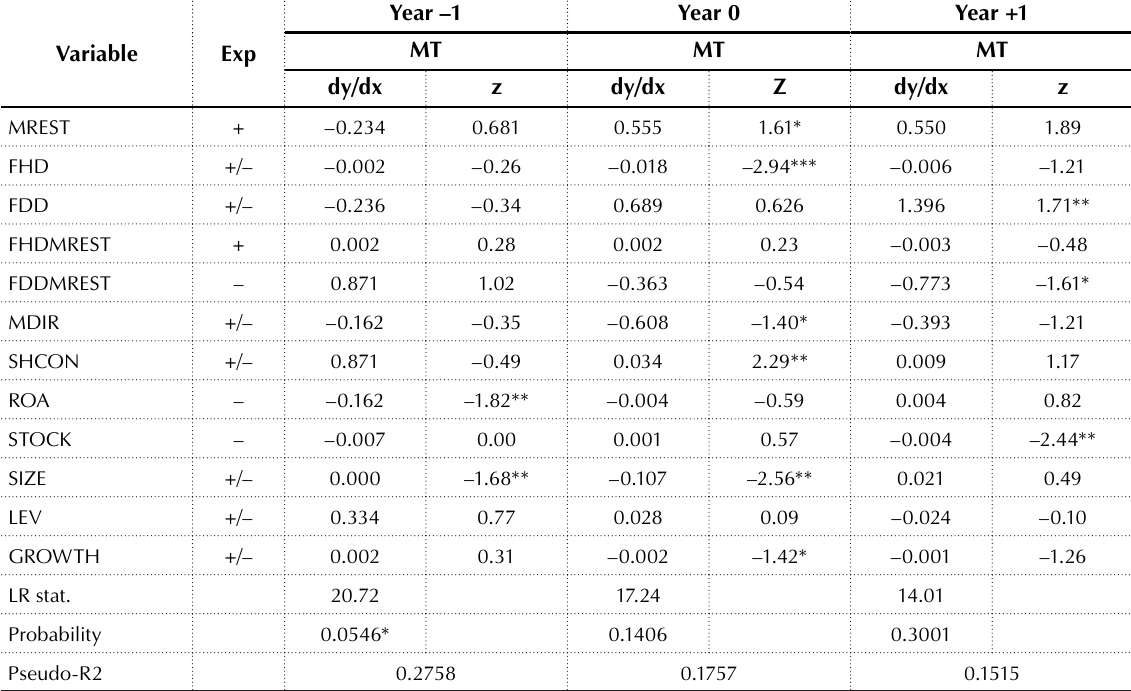
Table 3. Management turnover in a given year – independent variables with marginal effect